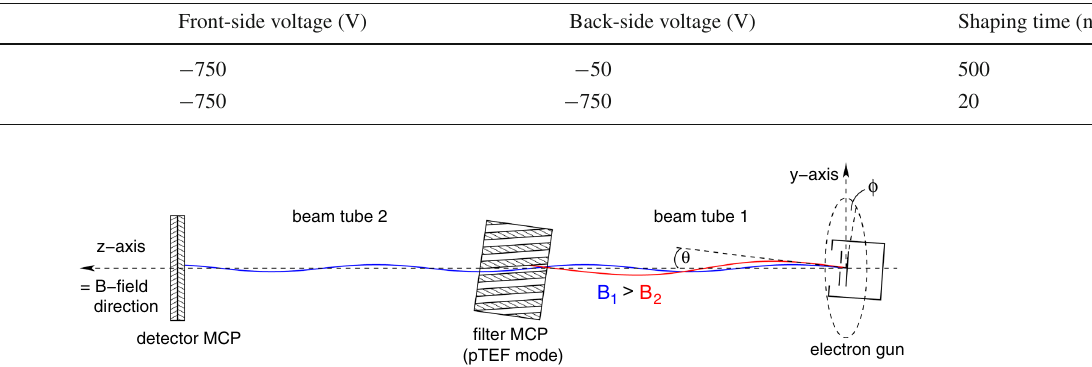
Fig. 4 Electron tracks in pTEF mode at two different magnetic-field strengths in beam tube 1 (drawing not to scale). Due to residual mis- alignments of the channels of the filter MCP and the magnetic field direction (parallel to the z-axis), a suitable combination of electron- gun angles (polar angle θ and azimuthal angle φ ) and magnetic field